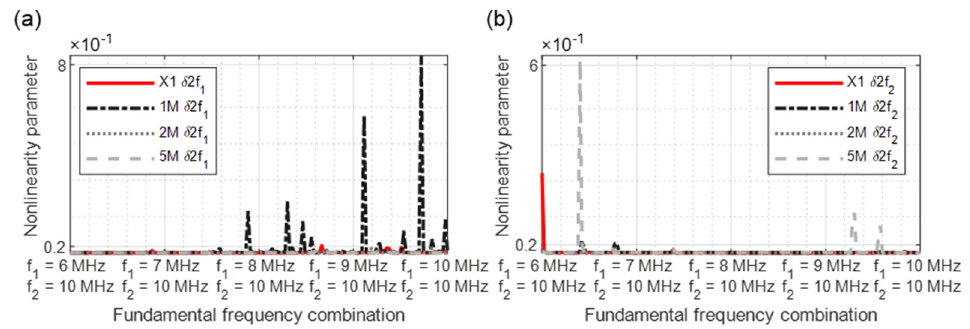
Figure 15. Nonlinearity parameter: ( a ) δ 2f 1 ; ( b ) δ 2f 2 .